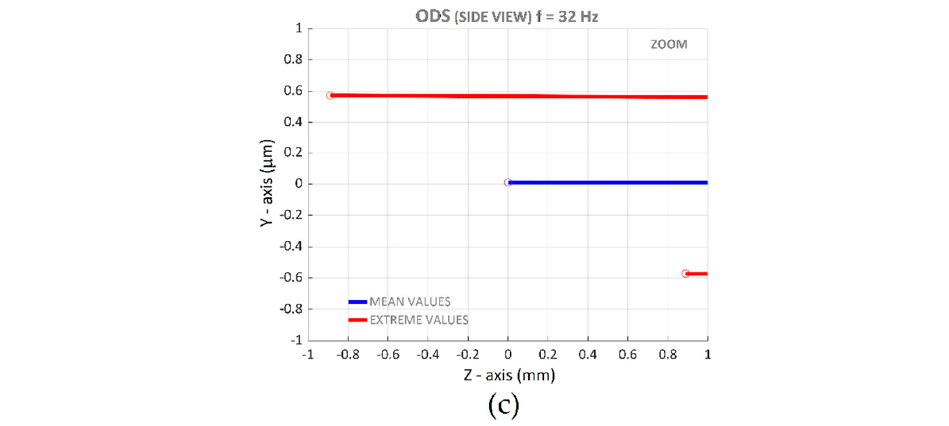
Figure 15. ODS of the tool at 32 Hz: ( a ) lateral view; ( b ) plant view; ( c ) zoom of lateral view.